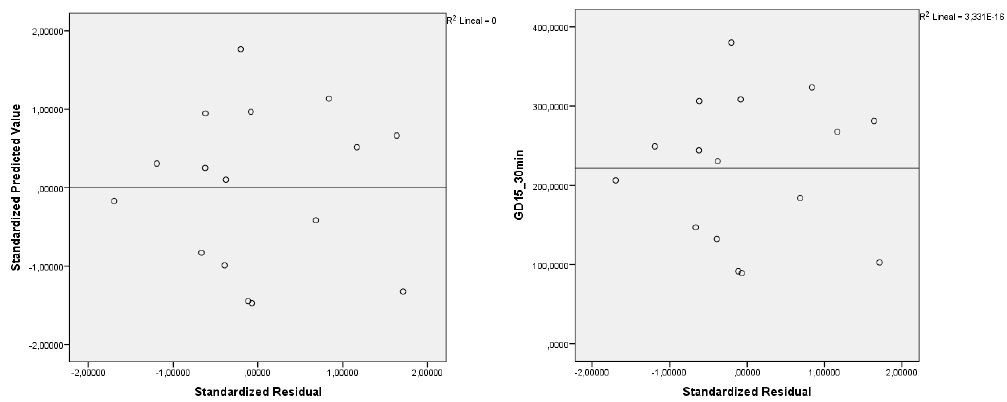
Figure 6. Compliance of homoscedasticity of residuals. D3 building.